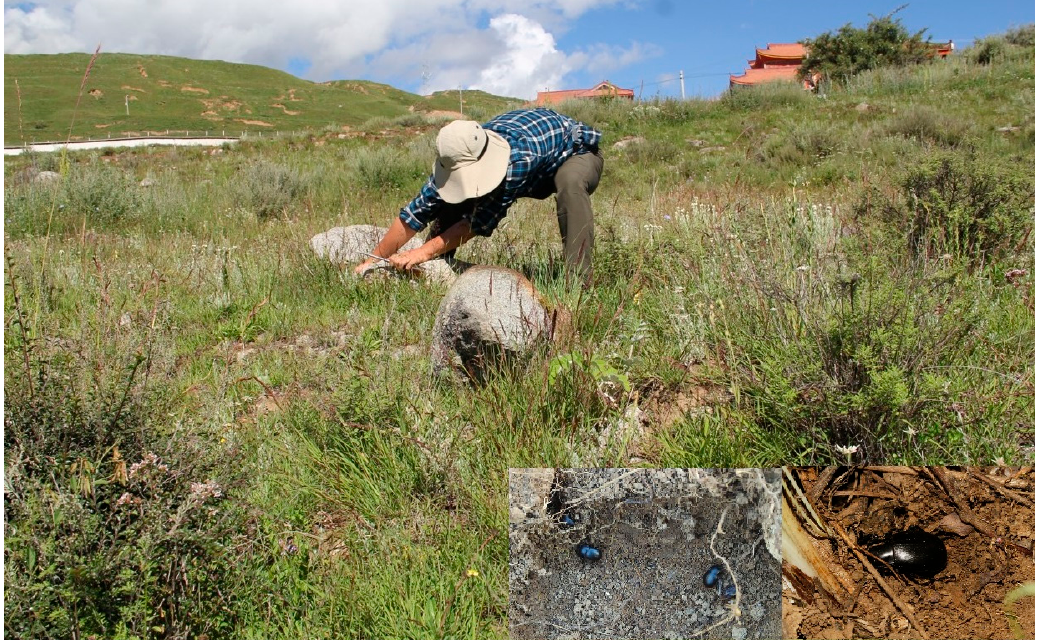
Figure 19. Habitat for Nalepa polita sp. n. photo by Xiumin Li, at Rinda, Luhuo, Sichuan, China, on 3 August